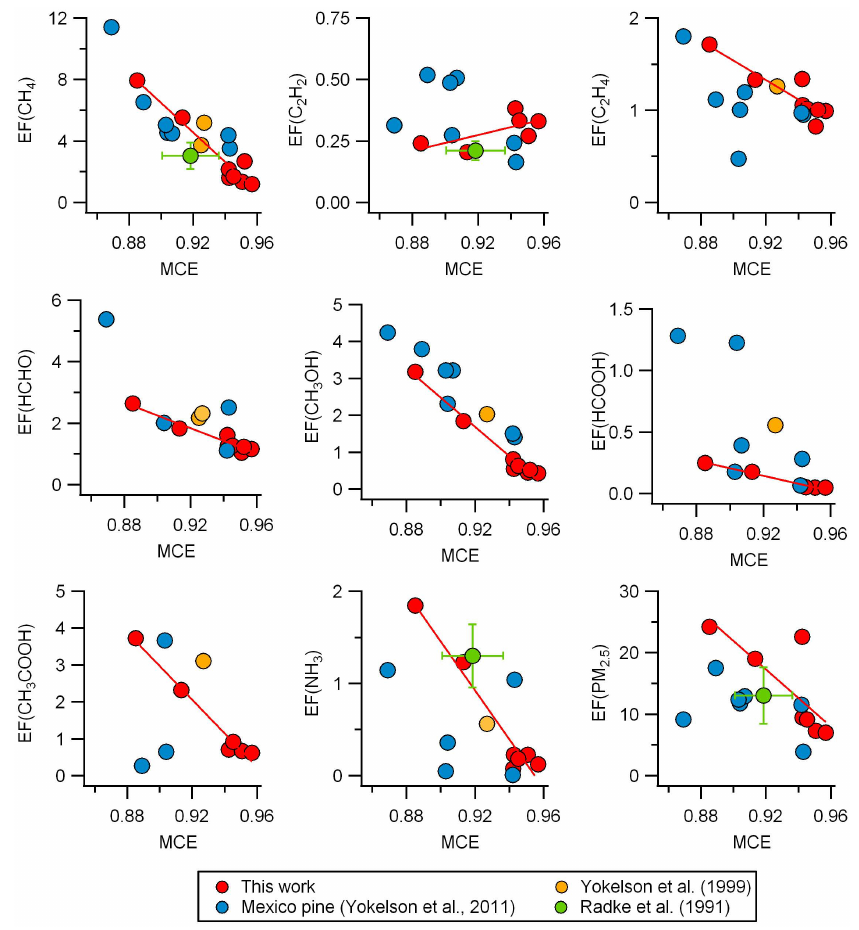
Fig. 1. Emission factors (gkg − 1 ) as a function of MCE for the conifer forest understory burns of this study (red circles). We also show the NC pine forest understory data of Yokelson et al. (1999), rural Mexico pine-oak data of Yokelson et al. (2011), and Radke et al. (1991). We show only the average and standard deviation of the Radke et al. (1991) data due to the high variability. Regression statistics are shown in Table 4 and apply only to the data collected in this